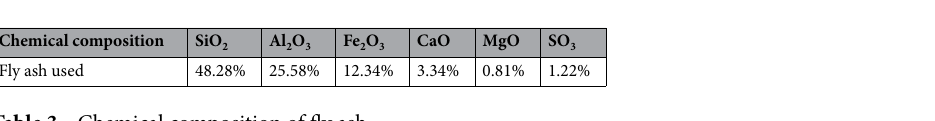
Table 3. Chemical composition of fly